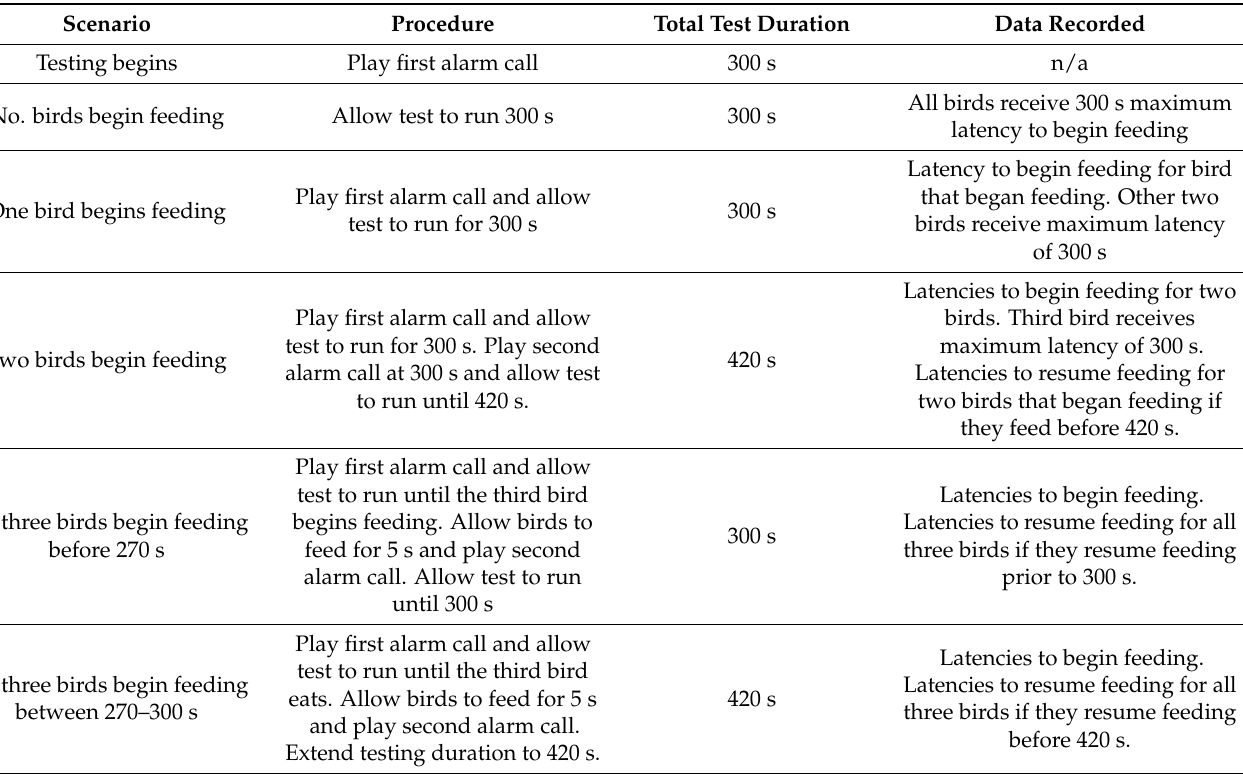
Table 1. Method that was used during attention bias (ABT) testing. The birds were tested in groups of three and the testing procedure differed depending on the number of birds who began feeding following the first alarm